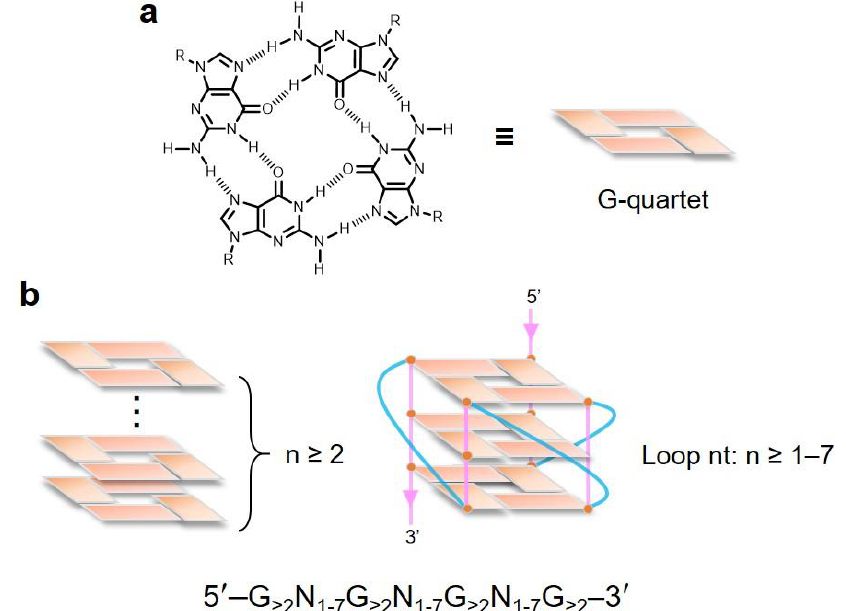
Figure 1. Characteristics of G-quadruplexes. ( a ) Chemical structure and schematic illustration of the G-quartet. ( b ) Schematic illustration of G-quadruplex structures. The G-quadruplex has at least two or three G-quartets, and three loops of varied length (1 – 7 nucleotides).